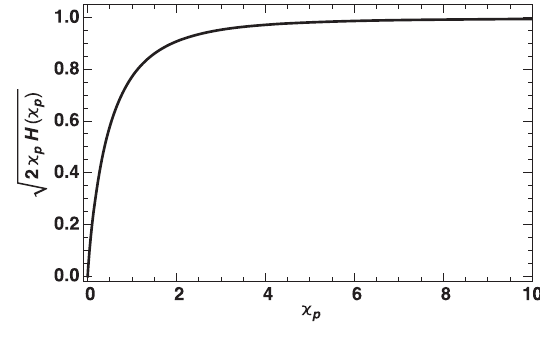
FIG. 3. Plot of the function